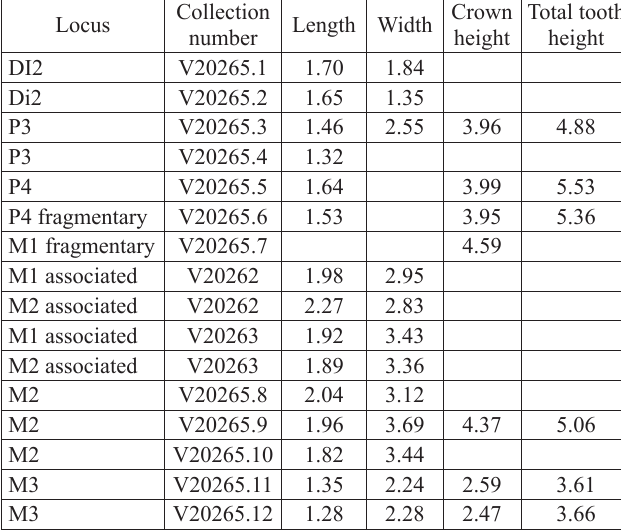
Table 3. Measurements (in mm) of incisors and upper teeth of Gobio- lagus aliwusuensis